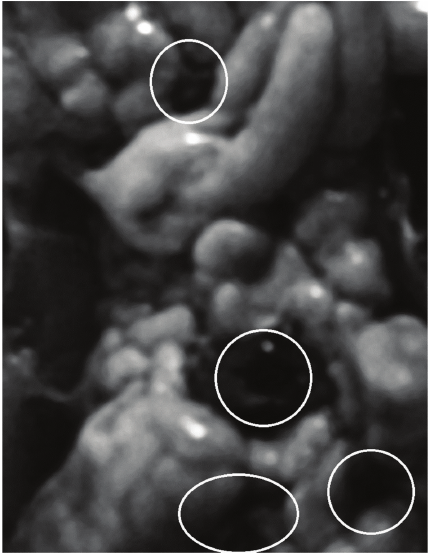
Figure 3: Hepatopancreas from lobster ( H. americanus ) experi- mentally infected with NHPB from penaeid shrimp ( L. vannamei ). White circles indicate blackish zones in which necrosis was